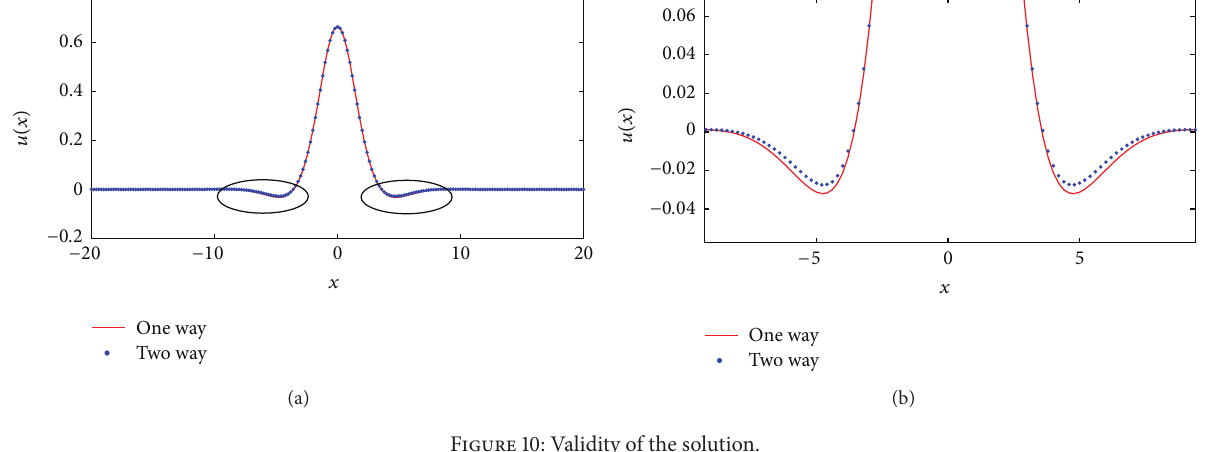
Figure 10: Validity of the